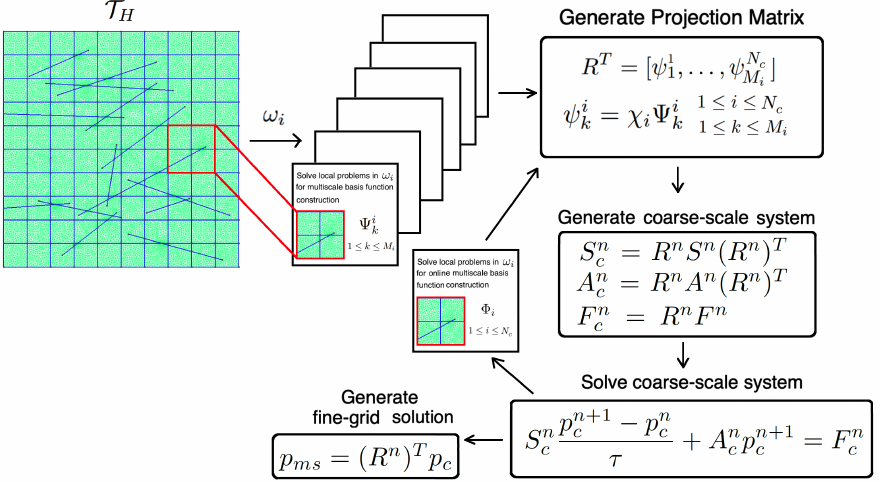
Figure 1. Illustration of the GMsFEM